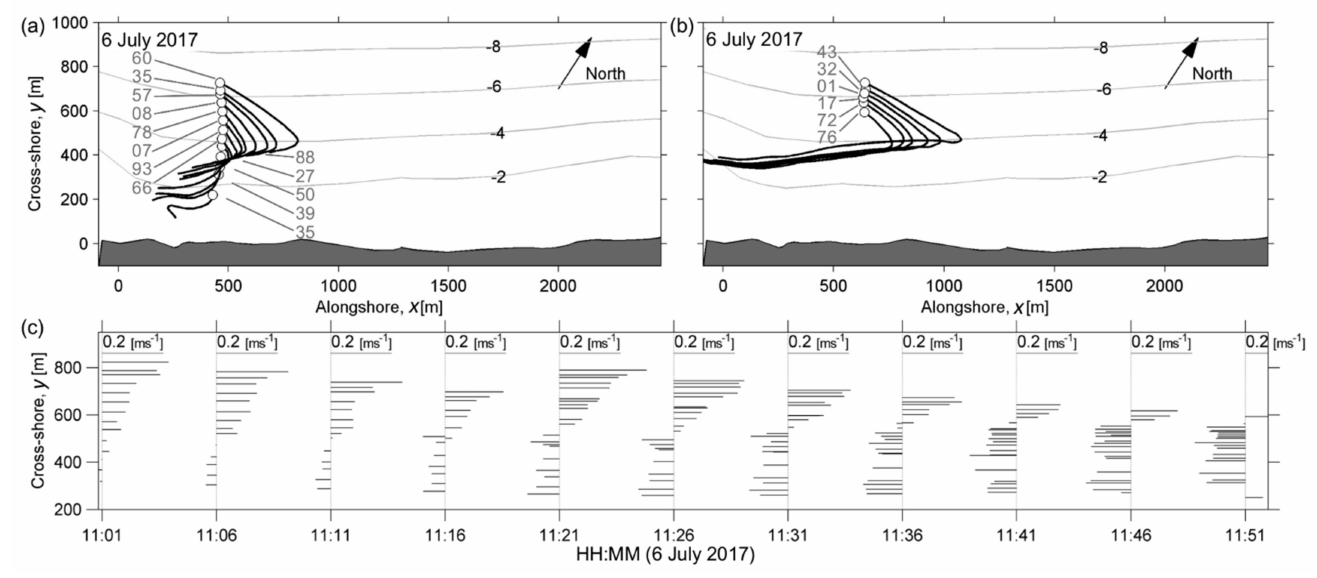
Figure 5. Case II experiment. Similar to Figure 4. ( a,b ) Trajectories of drifter clusters. ( c ) Alongshore velocity component measured by the sea-surface drifter clusters.